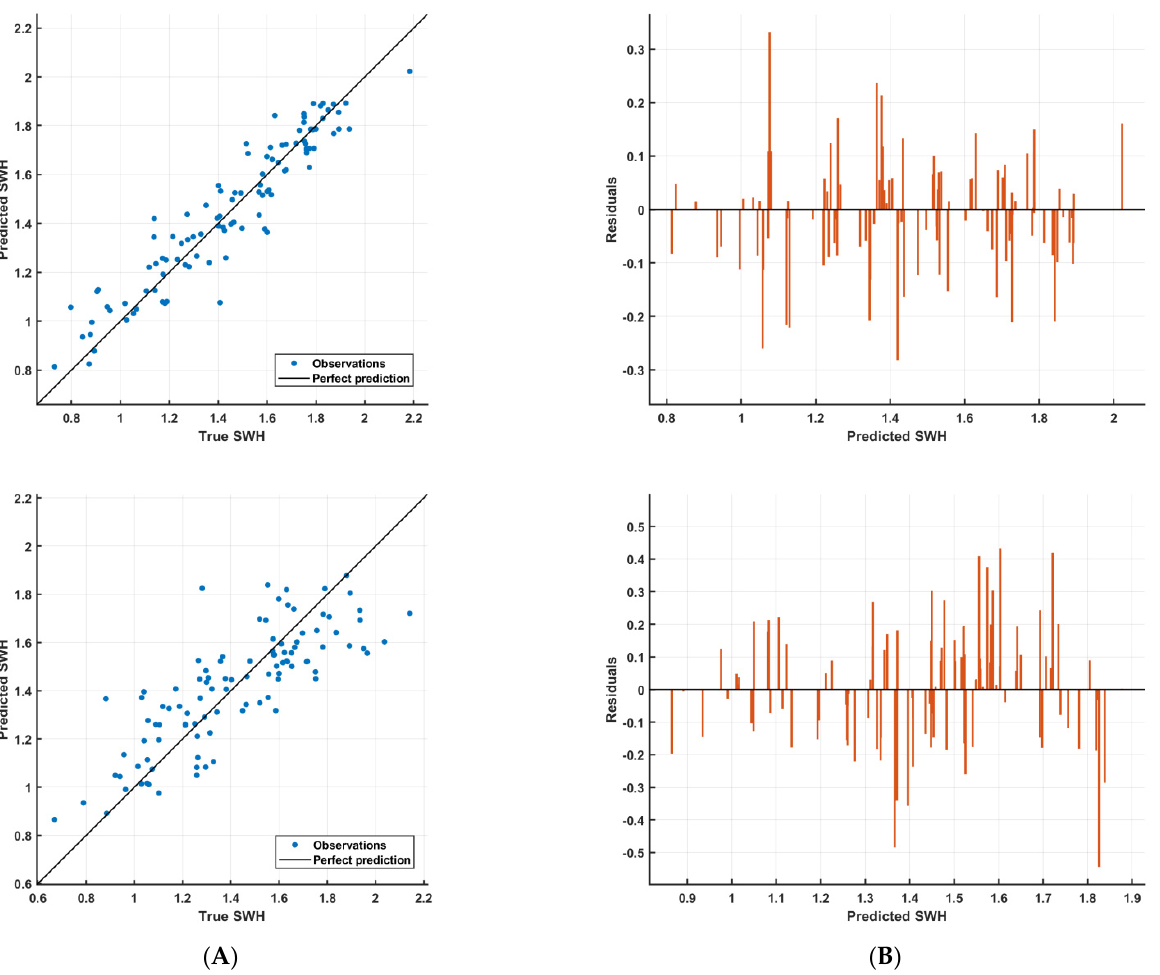
Figure 7. Testing prediction performance of the best performing regressors trained on the KU- based features of P1 data. ( A ) Predicted versus true SWH; ( B ) residuals versus predicted SWH; upper row: GPR model based on HAT-1; lower row: NNR model based on AUT-Set-3.